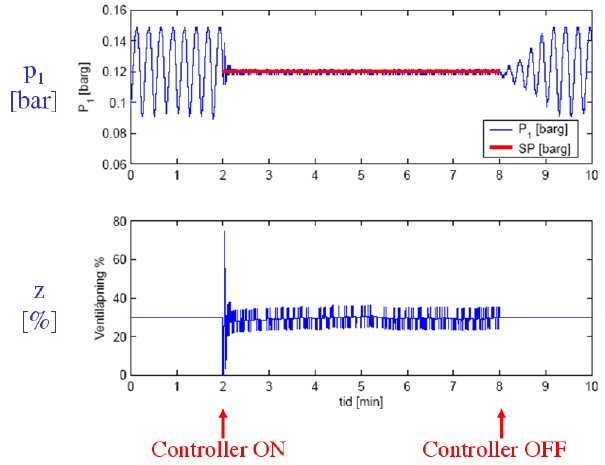
Figure 7: Anti-slug control: Response with feedback strategy in Figure